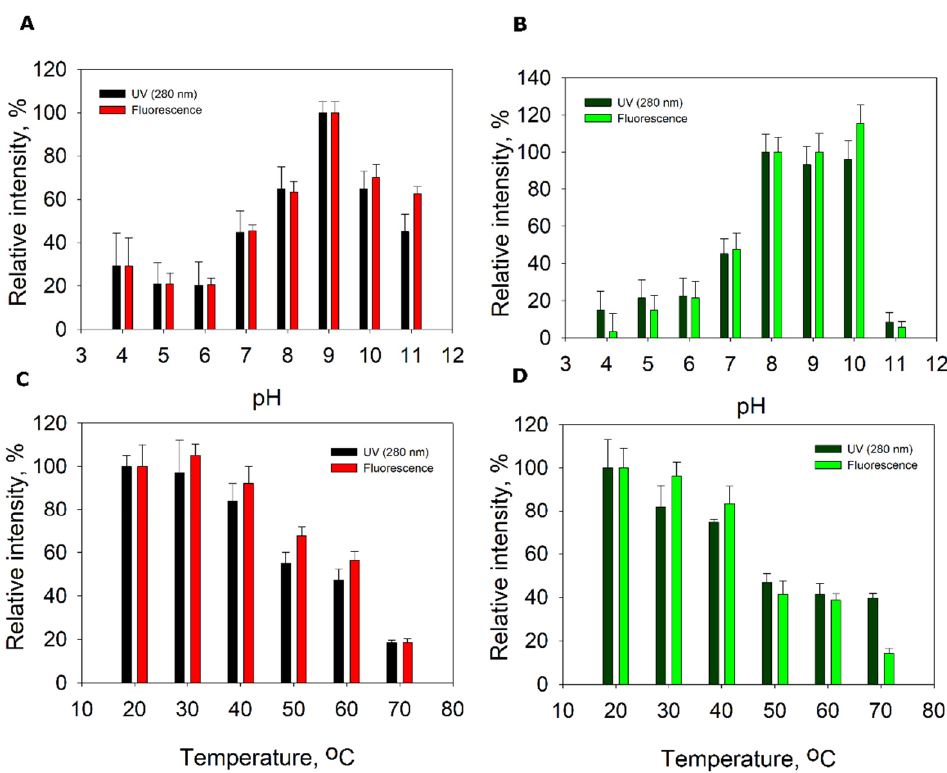
Figure 6. pH ( A , B ) and temperature ( C , D ) stability of hybrid 041 Δ 200GFP ( B , D ) and 041 Δ 200mCherry ( A , C ) nanotubes. The integrated areas of 10 min peak of absorbance at 280 nm and fluorescence at 610 nm (mCherry) or 506 nm (GFP) are shown.